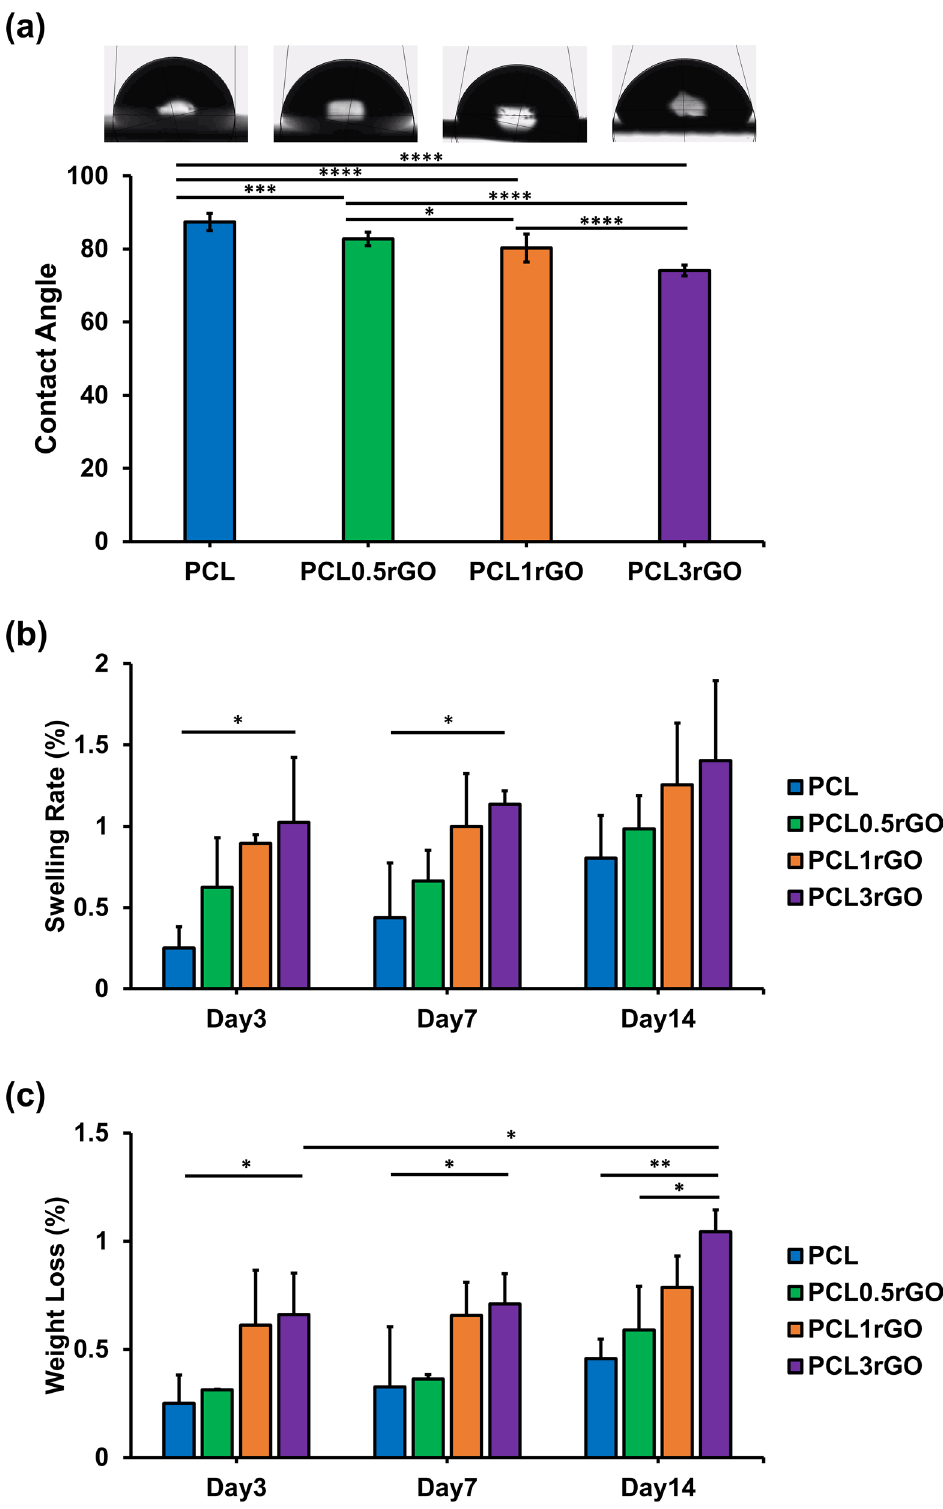
Figure 5. Characterization of the hydrophilicity and in vitro biodegradation behavior of the scaffolds. ( a ) The contact angle images and measurements of the scaffolds with different concentrations of rGO. Results are presented as mean ± SD (n = 5). ( b , c ) The in vitro degradation behavior of the 3D printed scaffolds after incubation in SBF over the course of 14 days and under physiological conditions. The ( b ) swelling rate and ( c ) weight loss of the scaffolds expressed in % and presented as mean ± SD (n = 3) (*p < 0.05, **p < 0.01, ***p < 0.001, ****p <